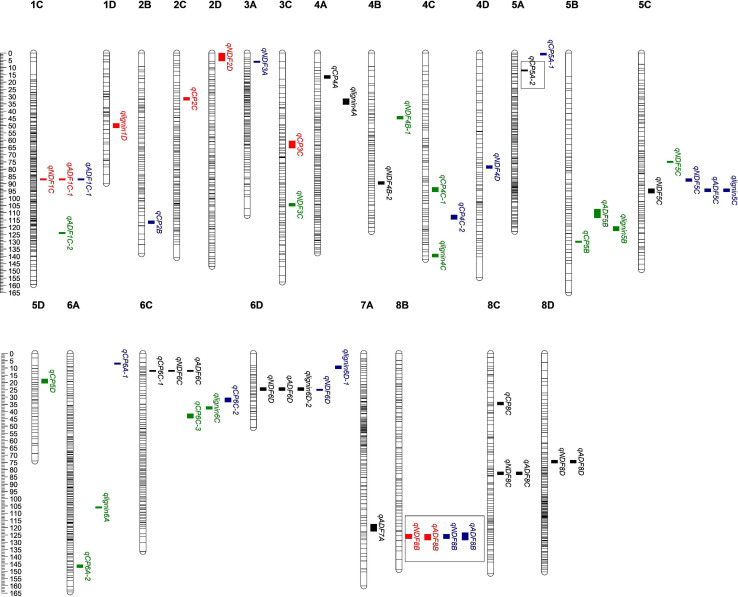
Quality-related QTL across the 32 linkage groups from a genetic map of maternal parent. The ruler on the left side represents the relative position of SNP on the chromosome. The small colored blocks represent QTL intervals. Black, QTLs in 2016; red, QTLs in 2019; green, QTLs in 2020; BLUP, QTLs of BLUP. The QTL in the box means it has been reported, qCP5A-2 (Biazzi et al., 2017); qNDF8B and qADF8B (Sakiroglu and Brummer, 2017).